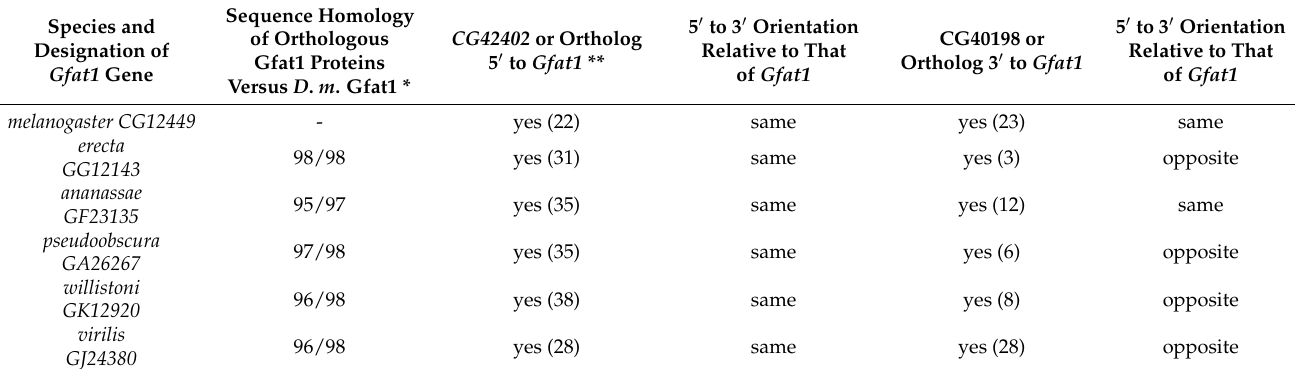
Figure 7. FISH localization of Gfat1 (red) and Gfat2 (green) in polytene chromosomes in six and five Drosophila species, respectively. For a description of the methods used, see Pimpinelli et al. [40] Note that Gfat1 is located within heterochromatin in D. melanogaster , D. erecta , and D. ananassae . This is confirmed for FISH using mitotic chromosomes for D. erecta and D. ananassae (see the insets). Gfat1 is euchromatic in D. pseudoobscura , D. willistoni , and D. virilis . Gfat2 is euchromatic in all species. Table 6. Microsynteny of two genes flanking Gfat1 or its ortholog in six Drosophila